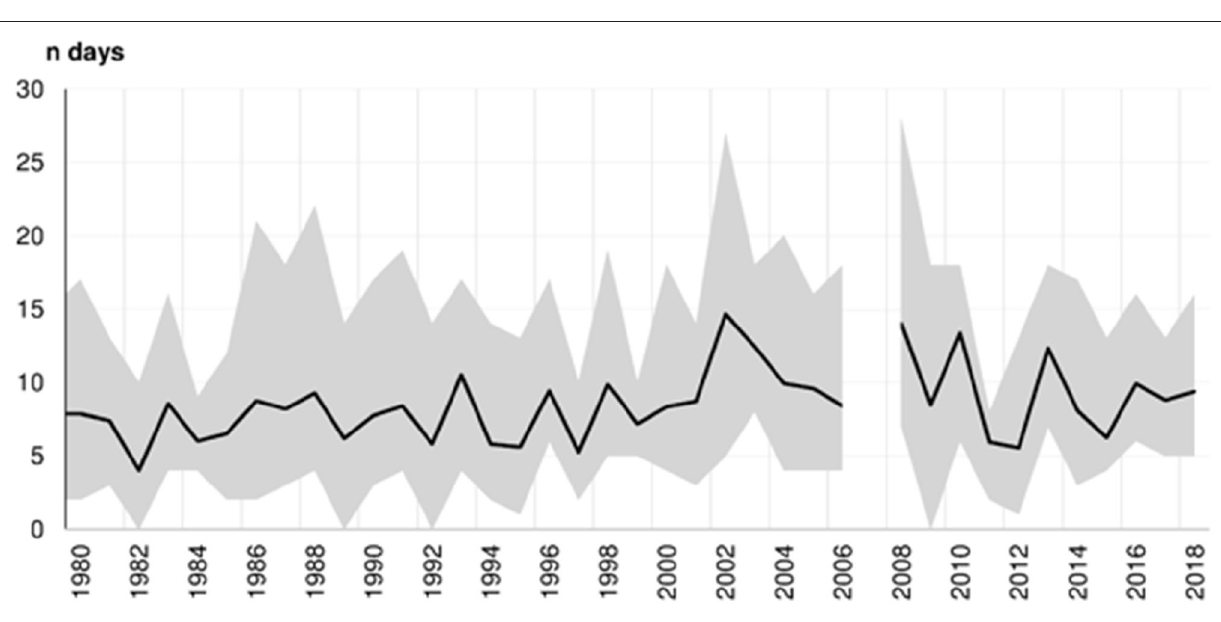
Frontiers in Water |